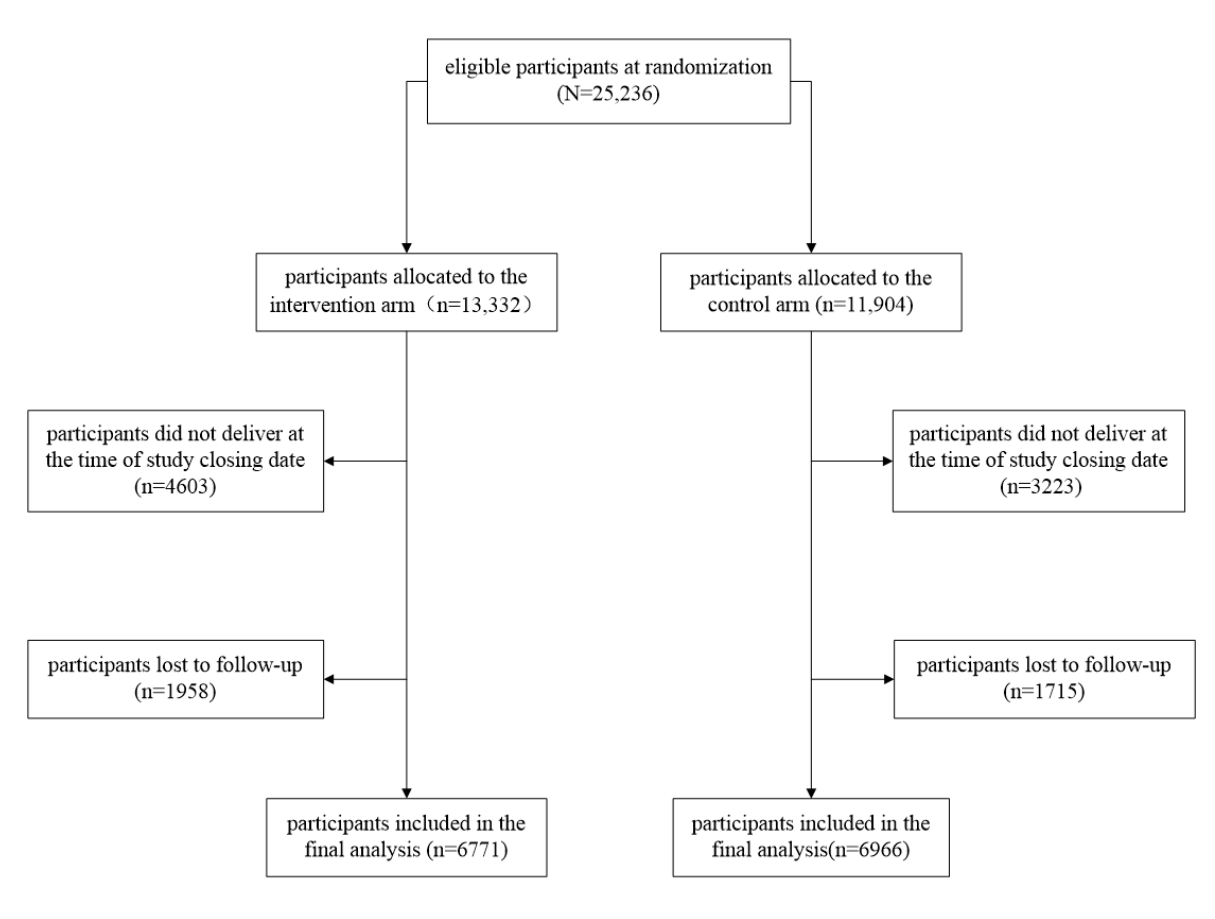
Figure 1. Flowchart of study participants of the text messaging trial in Hunan, China.